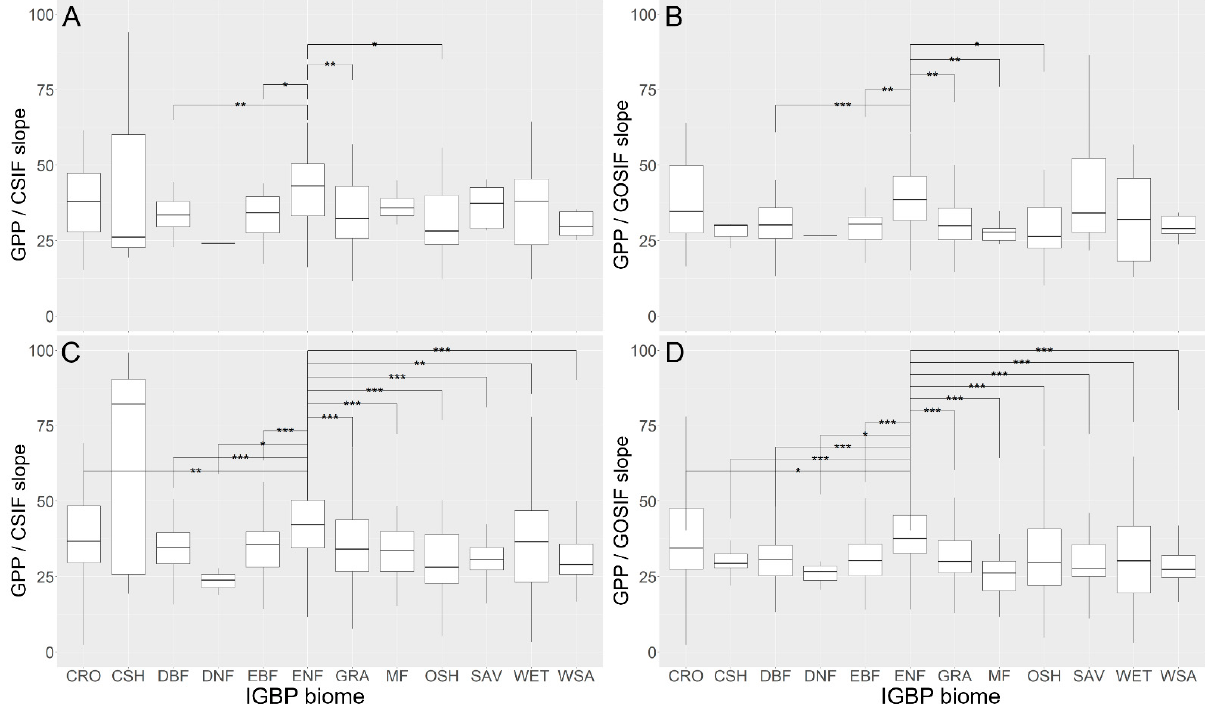
Figure 3. Boxplots and comparison of GPP/SIFc slopes between the 12 biomes are similar to those in Figure 1. ( A , B ) Site-multi-yearly slopes (basis of slopes calculated for whole time); ( C , D ) site-yearly slopes (basis of slopes calculated for each year). Each boxplot represents the distribution of GPP/SIFc slopes in the corresponding biome. The top and bottom of the boxes represent the 75 and 25 percentiles (i.e., Q3 and Q1), respectively; the solid line in the box is the median value of the box; the whole box is the interquartile range (IQR = Q3–Q1); the top and bottom whiskers represent the maximum and minimum values (i.e., Q3–1.5 * IQR, Q1–1.5 * IQR), respectively; the data outside of the maximum and minimum are shown as points beyond the whiskers. Site-yearly and site-multi-yearly slopes were derived from daily SIFc-GPP data obtained in a year and in the whole observation period for each site, respectively, using major axis regression. Black aster- isks indicate that the difference of mean GPP/SIFc slopes between two connected biomes is significant (***: p < 0.001; **: 0.001< p < 0.01; *: 0.01 < p < 0.05).